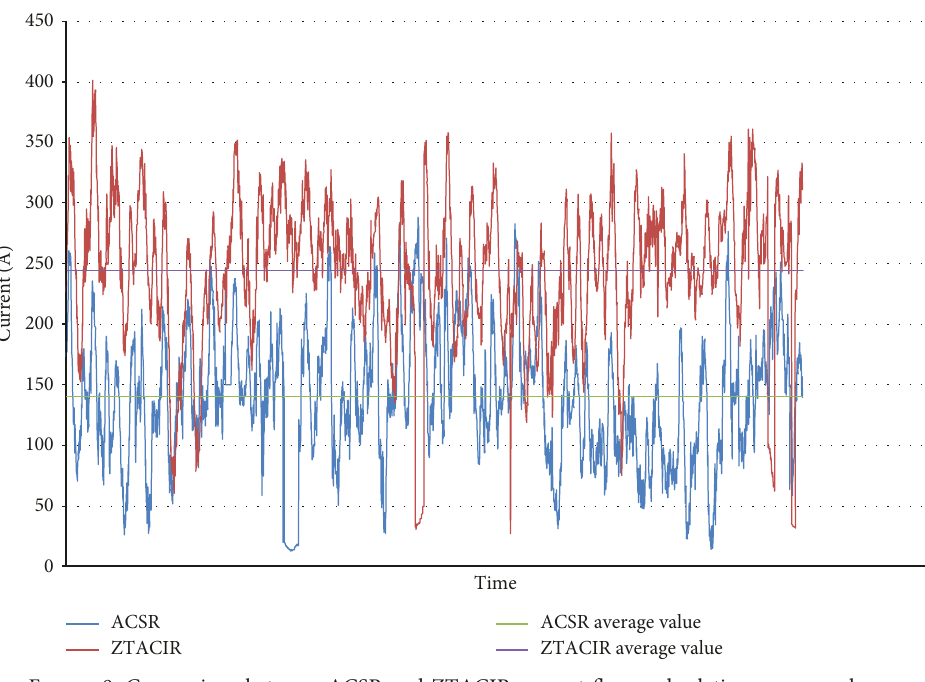
Figure 9: Comparison between ACSR and ZTACIR current flow and relative average values.